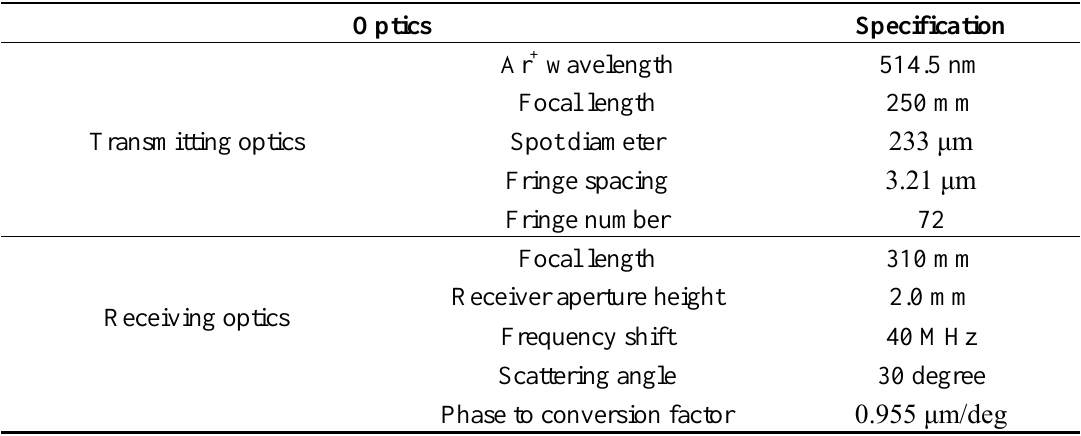
Table 1. Optical configurations for phase Doppler